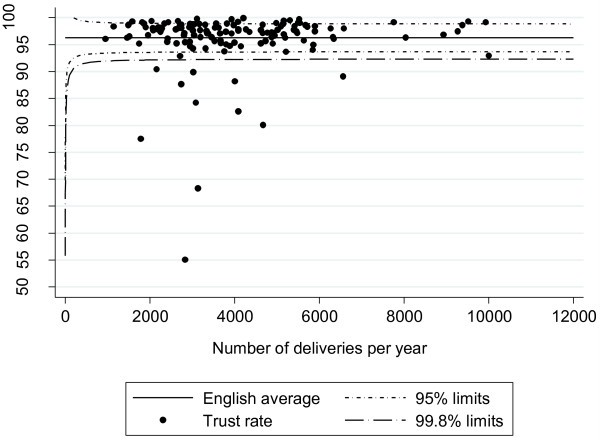
Funnel plot showing consistency between OPCS mode of delivery code and delmeth code for English NHS trusts (2009/10). The English average was calculated by dividing the number of records with consistent mode of delivery recorded in both fields by the total number of records containing information about mode of delivery in both fields.